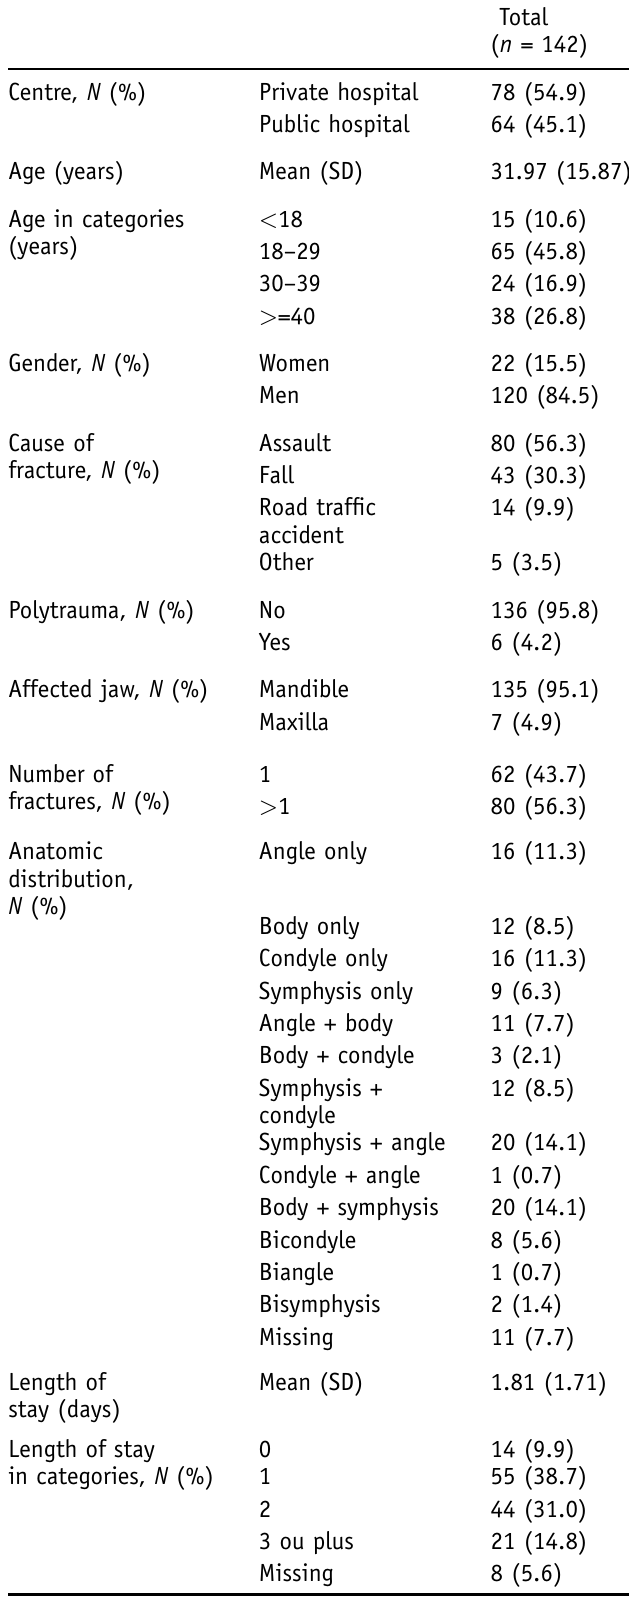
Table I. Description of patients ’ characteristics and of jaw